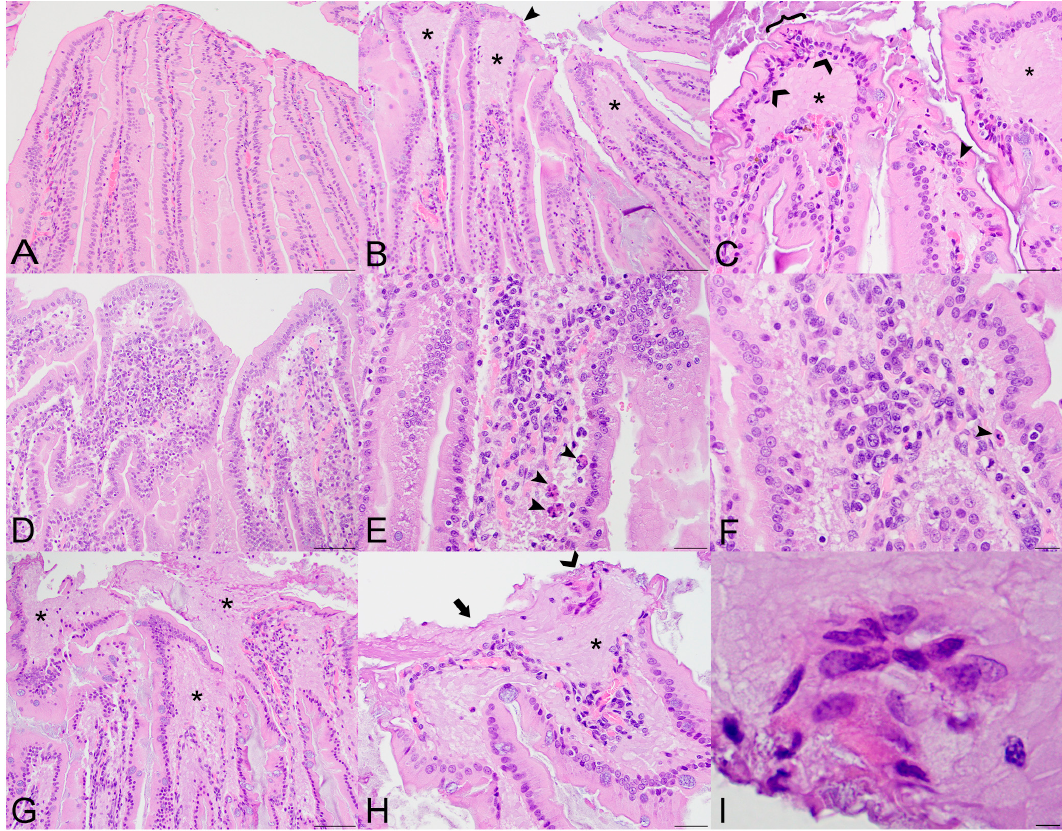
Figure 1. Histopathologic lesions in the small intestines of Sosuga virus (SOSV)-infected Egyptian rousette bats euthanized at 9 and 21 days post-inoculation (DPI). ( A ) Jejunum, control bat 290195. The intestinal villi are tall and slender with thin lamina propria cores. HE stain; original magnifica- tion = 200×; bar = 50 µm. ( B ) Jejunum, 9 DPI bat 287756. The villus tips are swollen with an accumu- lation of a paucicellular, eosinophilic fluid (*) that elevates the epithelium and compresses the lam- ina propria core. A villus tip is focally ulcerated (arrowhead). HE stain; original magnification =